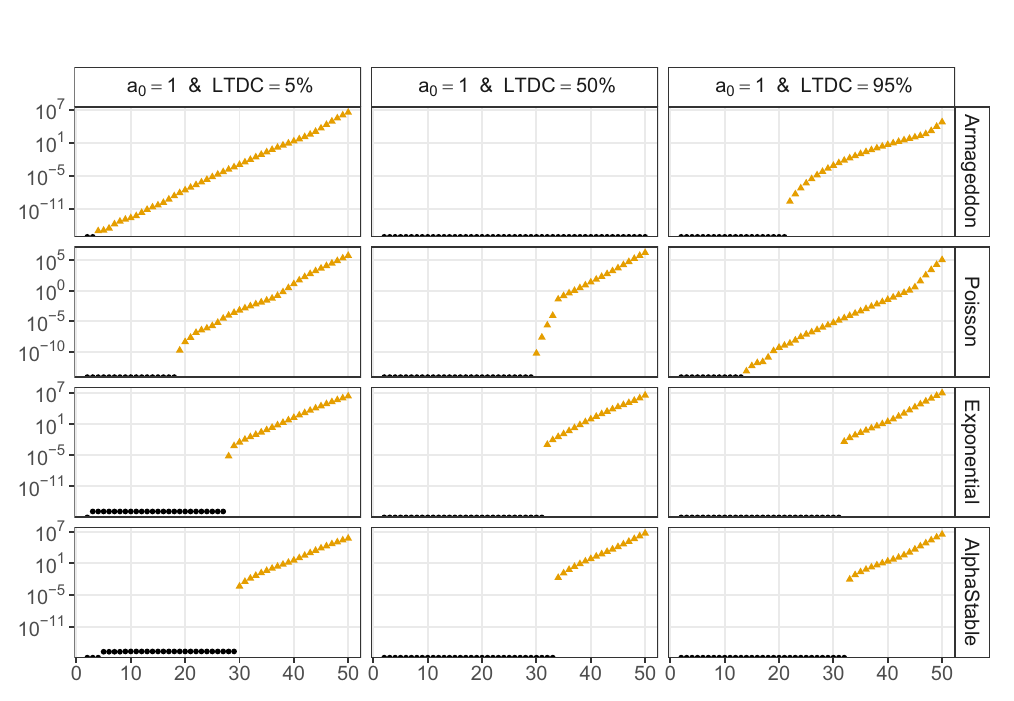
Figure 1: The maximum relative di ff erences ( ) ε d 1 of the o ff - diagonal row sums for the naïve approximation of ∗ Q for ≤ ≤ d 2 50 ; yellow coloring and triangle shape indicate whether fl ooring was